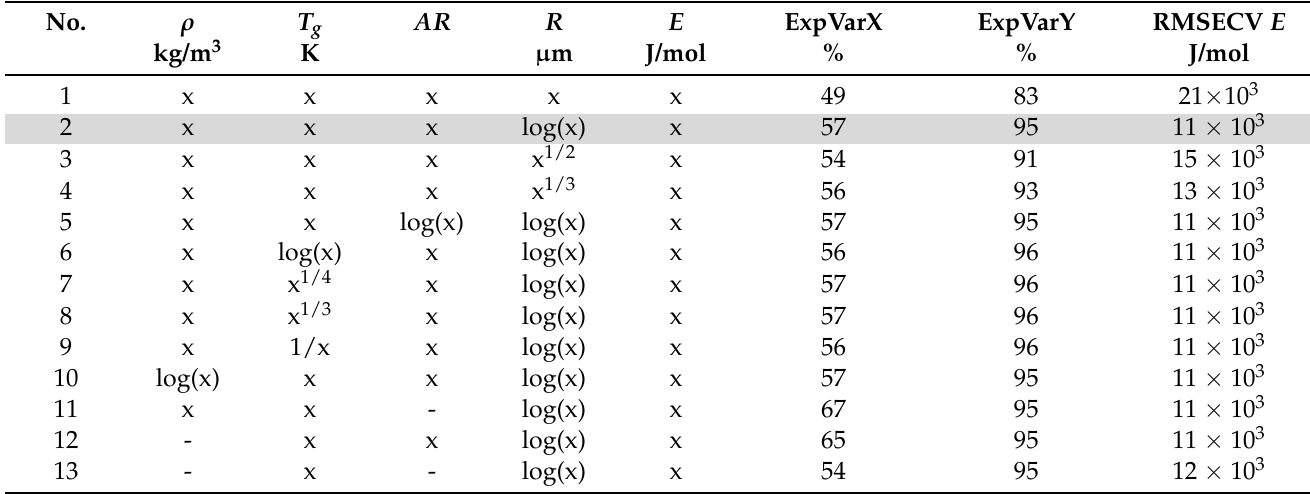
Table 4. Table of tested PLS models for obtaining values of E . All models have two PLS components. ExpVar = explained variance, RMSECV = root means squared error of cross validation. x = parameter included, - = parameter not included.